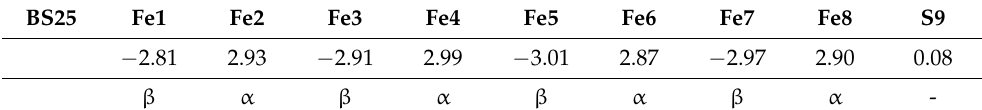
Table 1. Electronic state analysis of the spin densities of the BS25 state after geometry optimization. α is conventionally indicated as being positive and β negative.